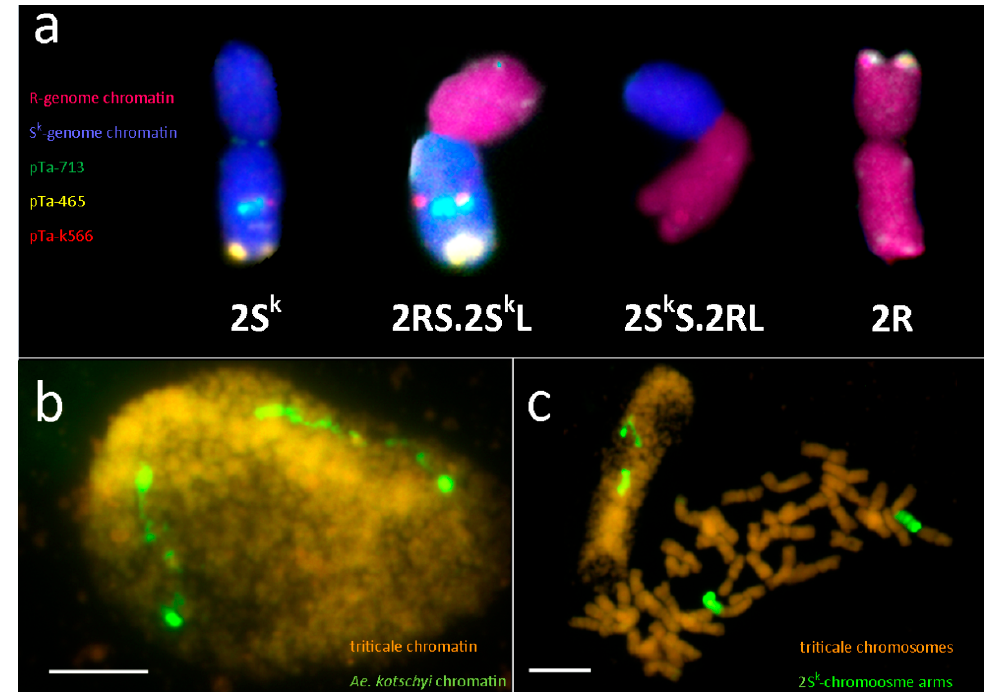
Figure 5. ( a ) T2S k .2R Robertsonian translocations in triticale analysed by fluorescence in situ hybridization (R-genome chromatin—purple, S k -genome chromatin—blue, pTa-713—green, pTa-465—yellow, pTa-k566—red). Genomic in-situ hybridization pattern of triticale plant carrying Robertsonian traslocations with segments of 2S k chromosome (green) at prophase ( b ) and metaphase ( c ) of root meristem cell. Scale bar, 10 μ m.